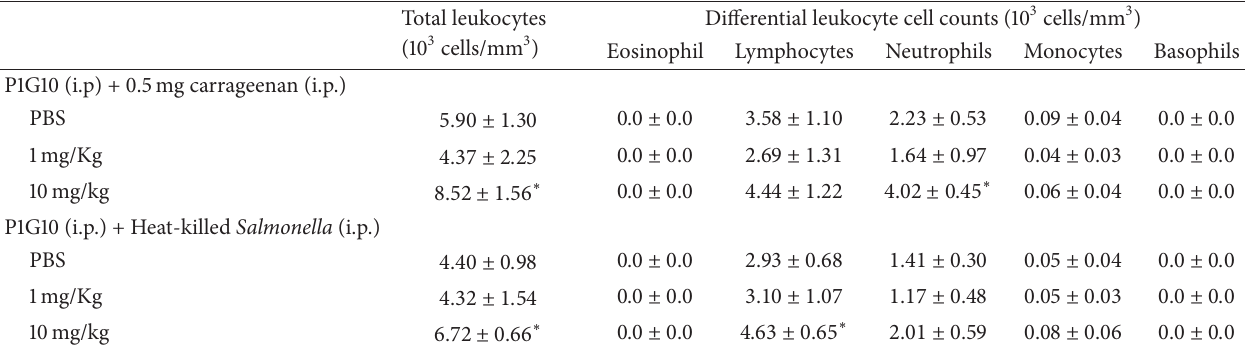
Table 1: Leukocyte cell counts in the bloodstream of Swiss mice pretreated with P1G10 6 h after injection of carrageenan or heat-killed S. Typhimurium into the peritoneal